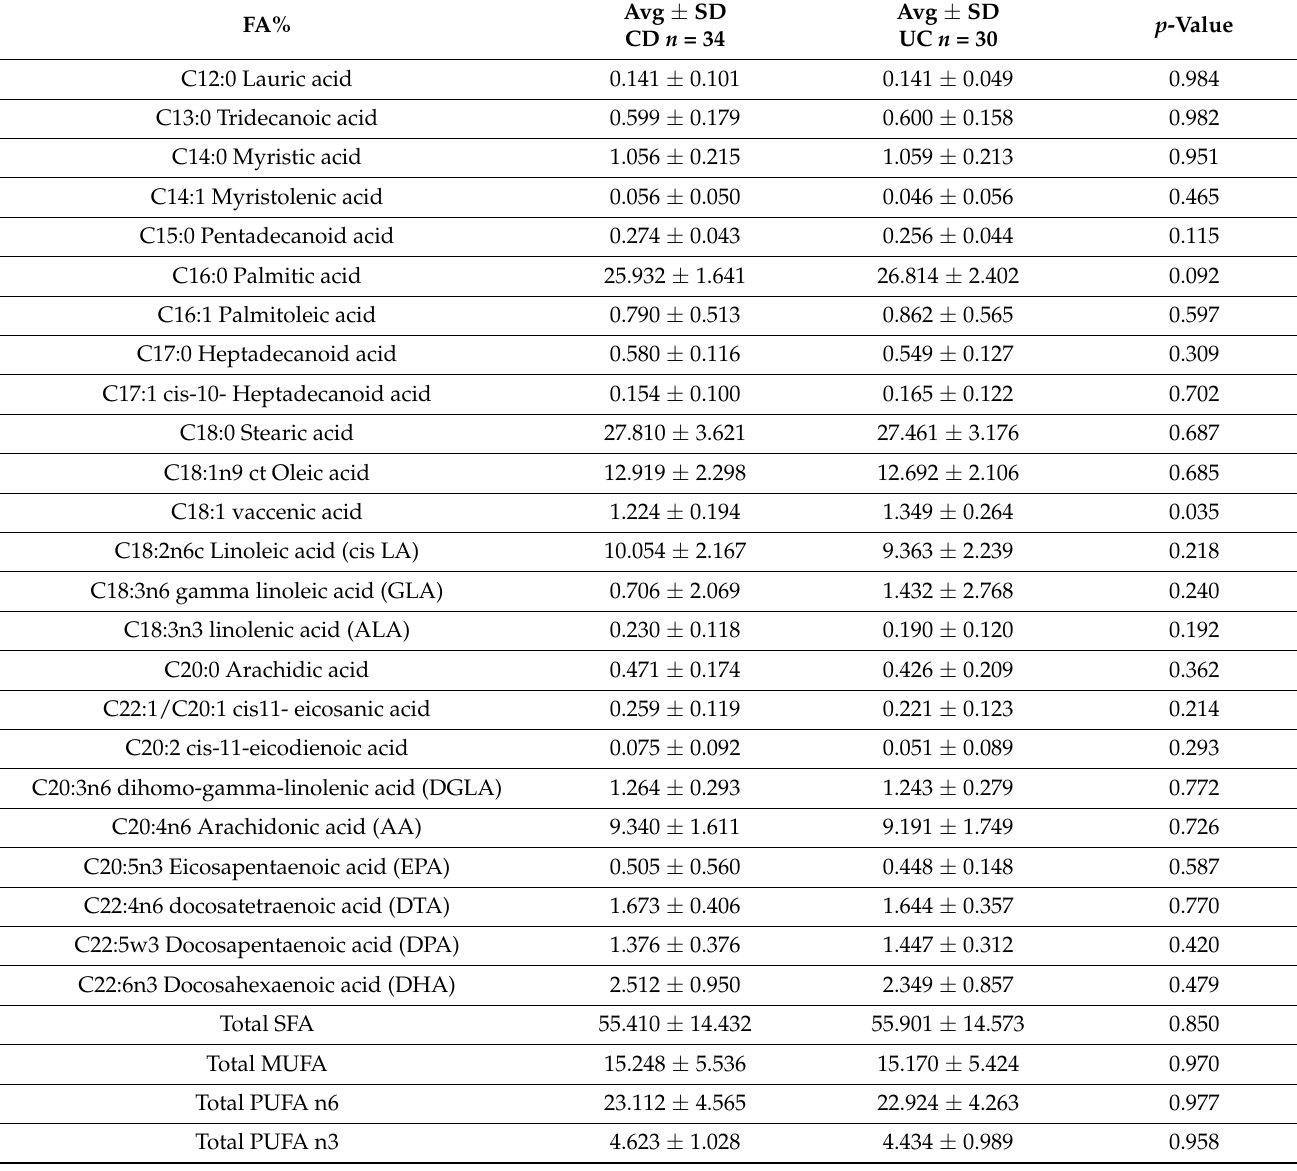
Table 2. Characteristics of fatty acids in CD and UC groups.